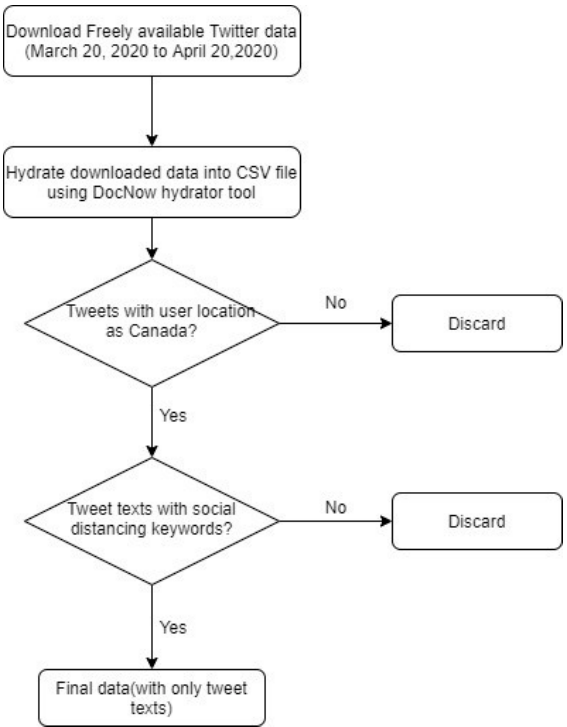
Figure 1. Data collection